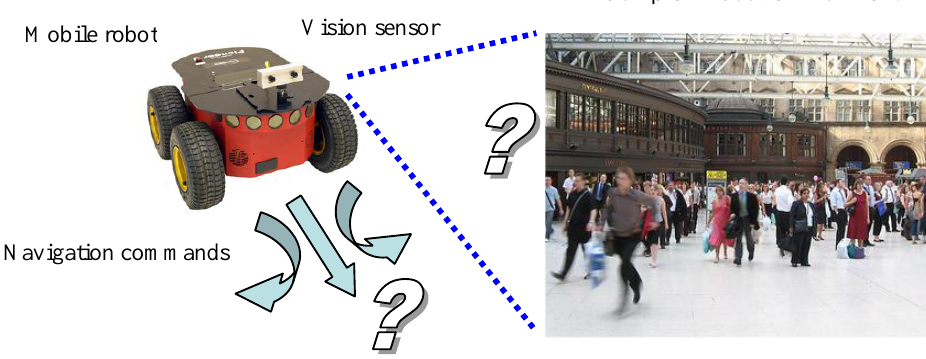
Figure 1. Framework and typical scenario: mobile robot navigation through complex and crowded indoor